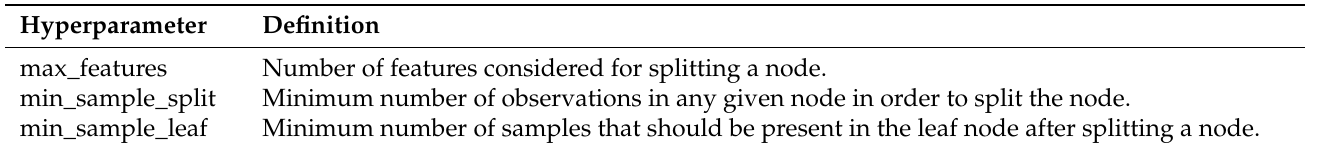
Table 1. Random forest hyperparameter